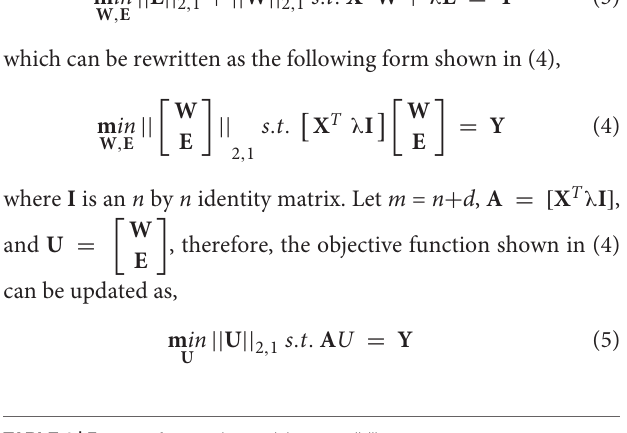
TABLE 1 | Factors of enterprise social